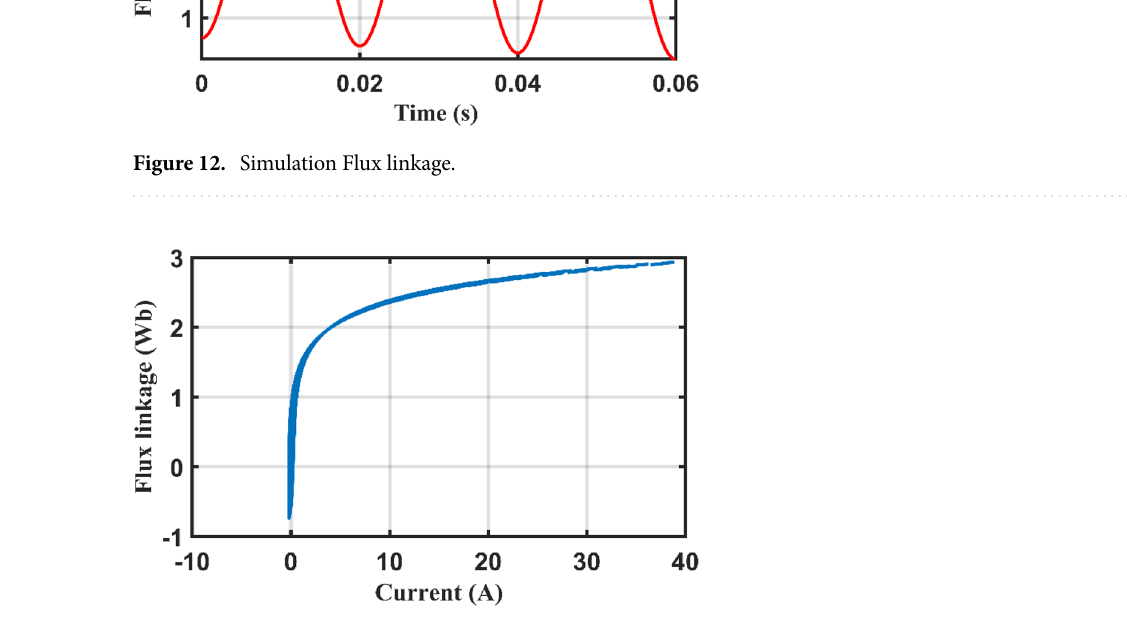
Figure 13. Simulation magnetization curve (flux linkage and